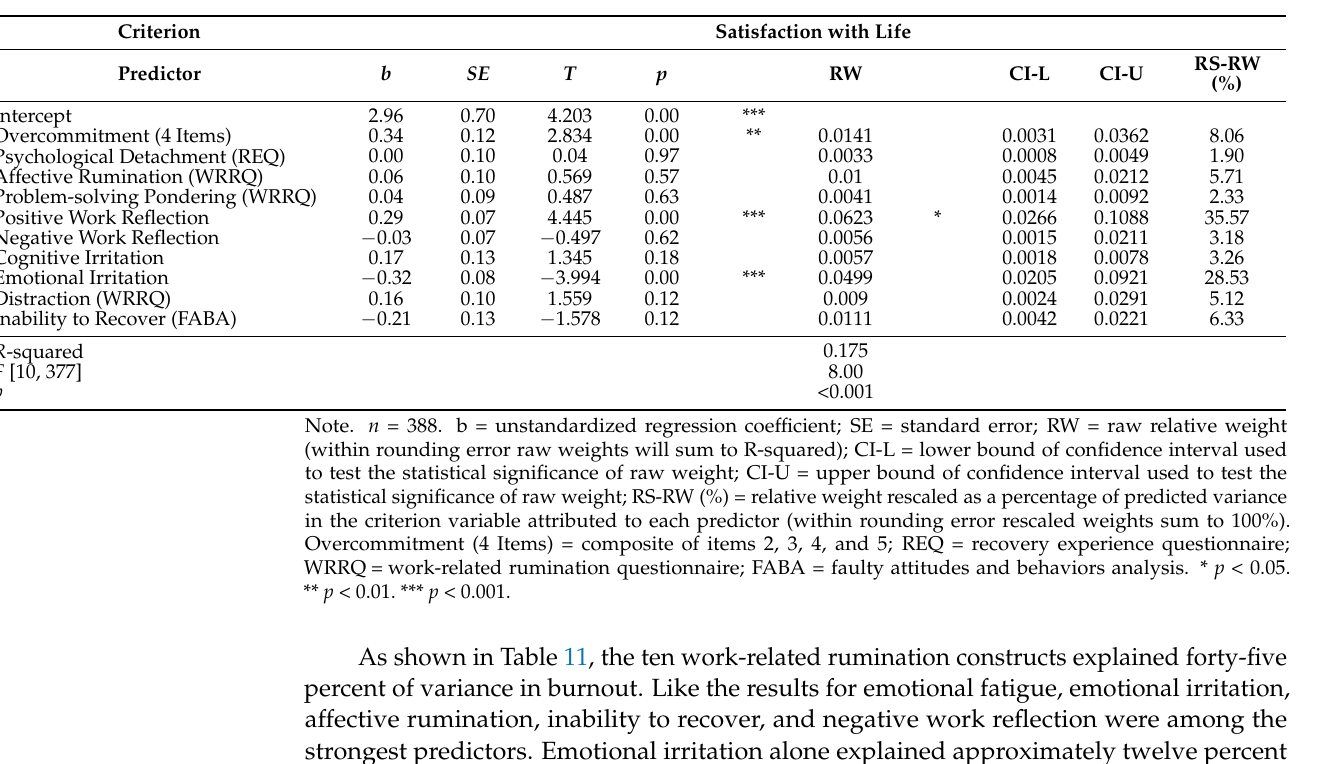
Table 13. Coefficients of the Relative Weight Analyses Predicting Satisfaction with Life (Sample